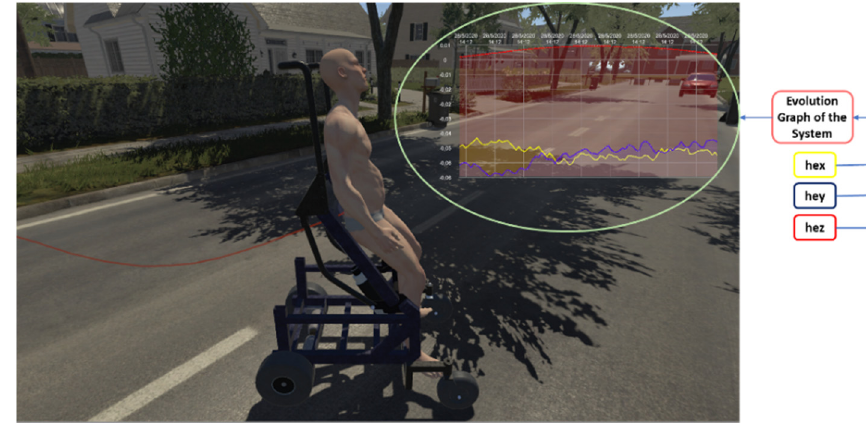
Figure 8. Data visualization of the control errors evolution in the graphics engine.